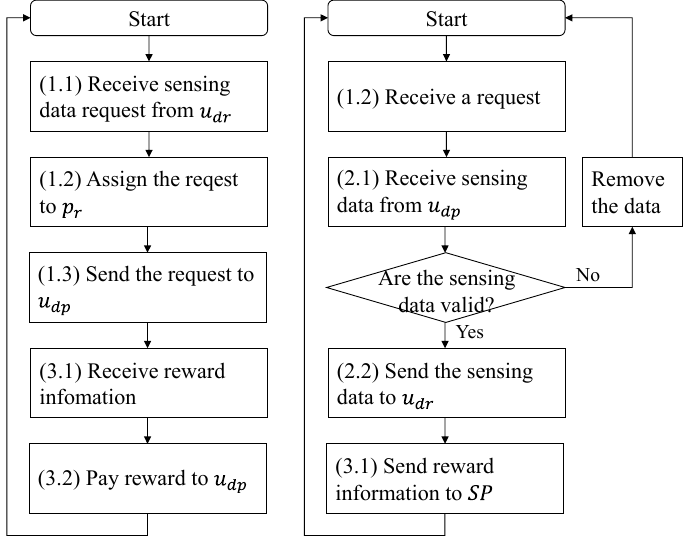
Figure 4. Process flows of proposed system.